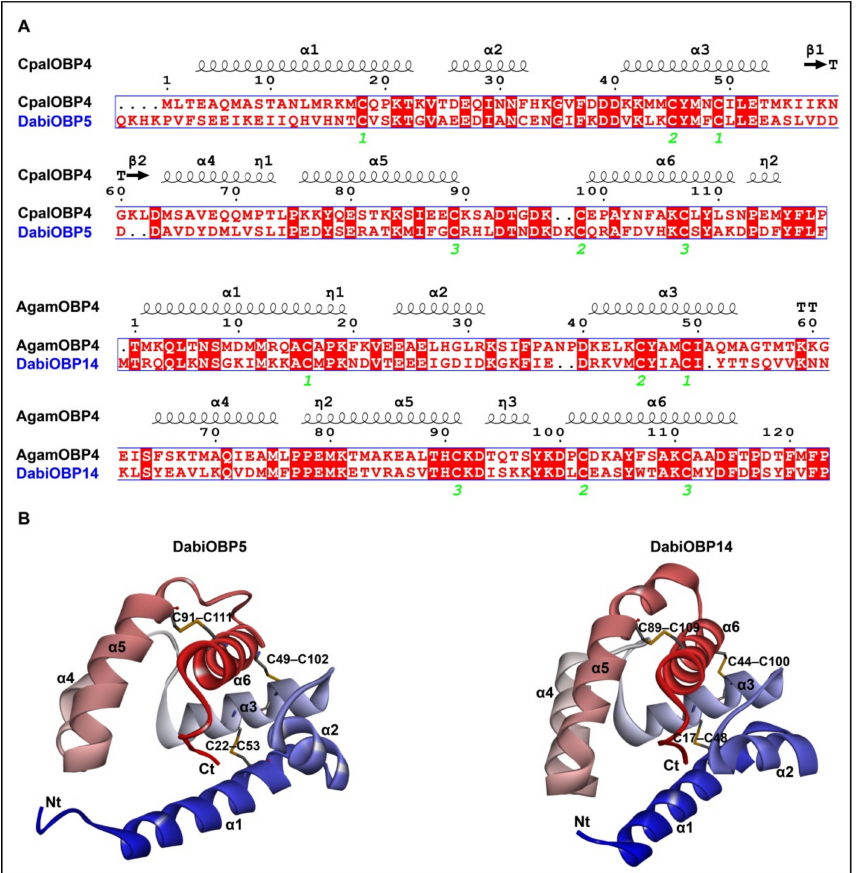
Figure 5. Three-dimensional (3D) structures of two DabiOBPs in D. abietella . ( A ) Alignments of amino acid sequences between DabiOBP5 and CpalOBP4 in C. pallens , or DabiOBP14 and AgamOBP4 in A. gambiae . Six α -helixes ( α 1– α 6) are labeled on the top of the alignments. Green numbers 1 to 3 at the bottom of the alignments represent conserved cysteines forming three disulfide bonds. ( B ) Predicted 3D models of DabiOBP5 and DabiOBP14. N–terminus (Nt), C–terminus (Ct) and α -helixes are indicated,